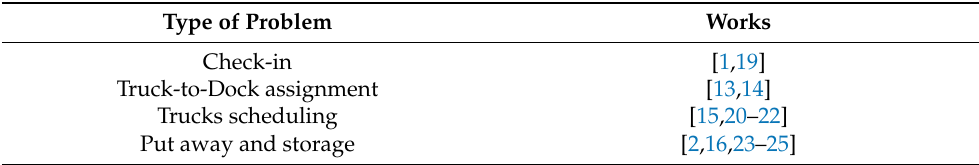
Table 1. Studies in the literature about the warehouse reception